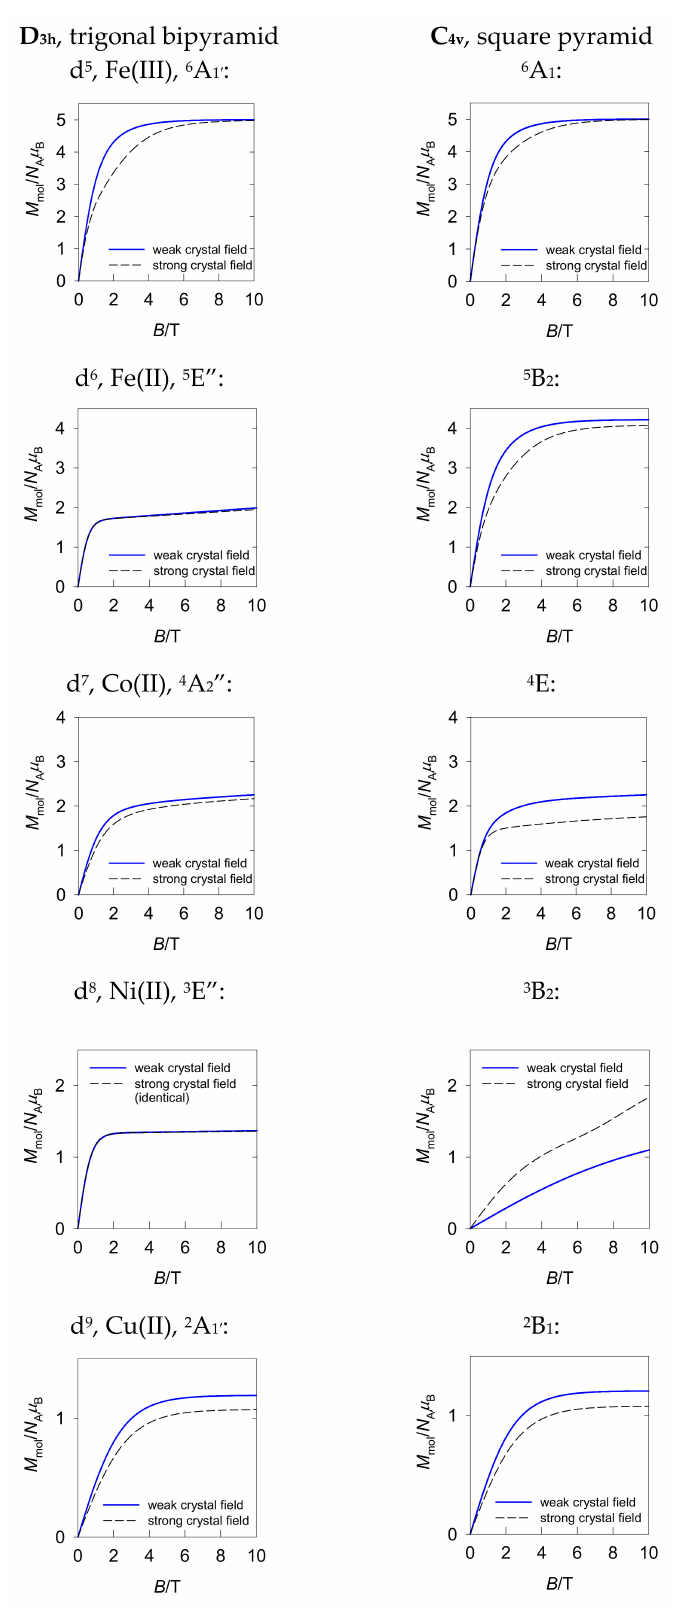
Figure 3. Magnetization functions at T = 2.0 K calculated by GCFT for a weak (strong) crystal field with F 4 = 5000 (15,000) cm − 1